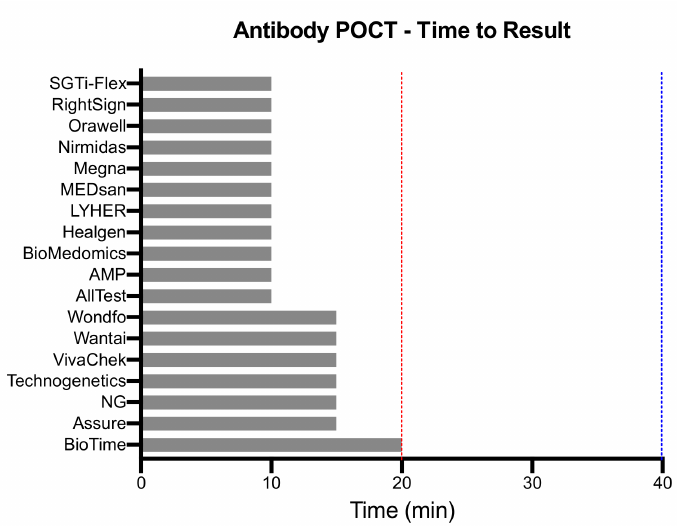
Figure 6. Time to result of selected indirect POCTs. The time to result of antibody POCTs that met the WHO “desirable” clinical sensitivity criteria (see Figure 2) based on manufacturer’s claims. Blue and red lines represent the WHO TPP “acceptable” and “desirable” thresholds,